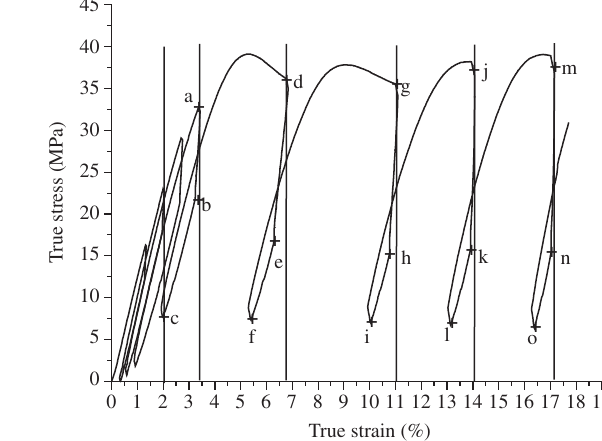
Figure 12. Stress-strain curves with cycles for stress relaxation.